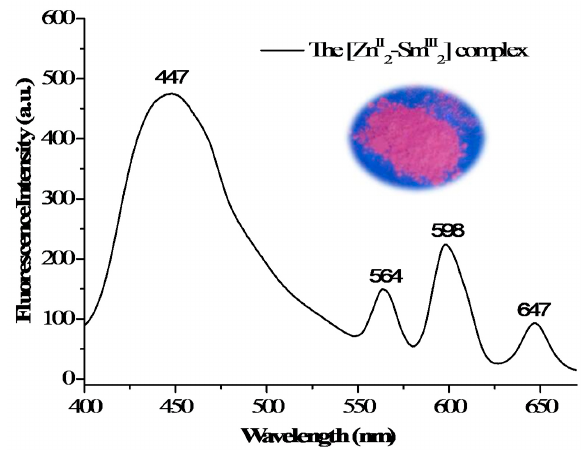
Figure 5. The solid fluorescence spectrum of the [Zn II2 – Sm III2 ] complex.